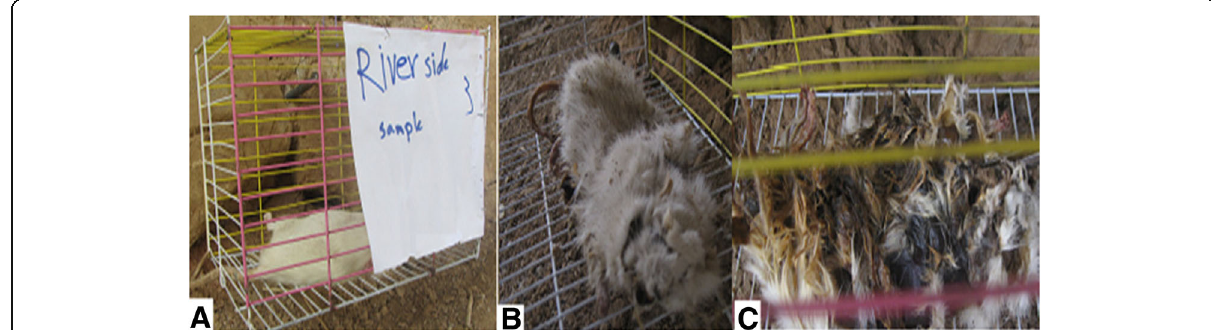
Fig. 3 Wistar rat decomposition stages ( a . Fresh stage, b . decay stage, c .